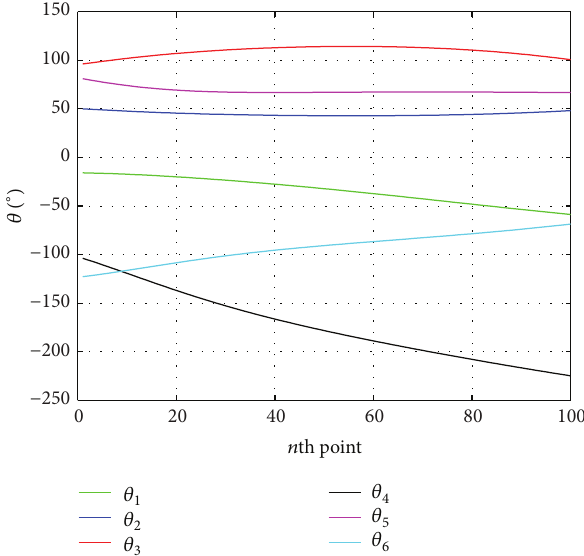
Figure 5: Joint position in the trajectory of the proposed method.